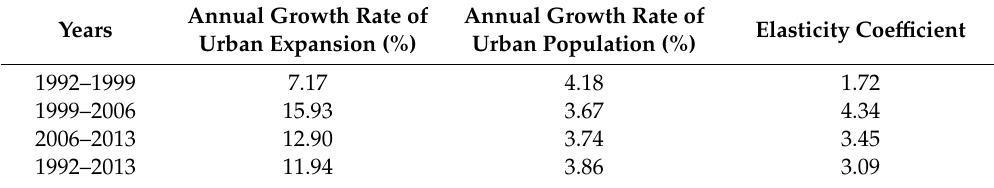
Table 4. The elastic coe ffi cient of urban expansion in the YREB in di ff erent time periods.